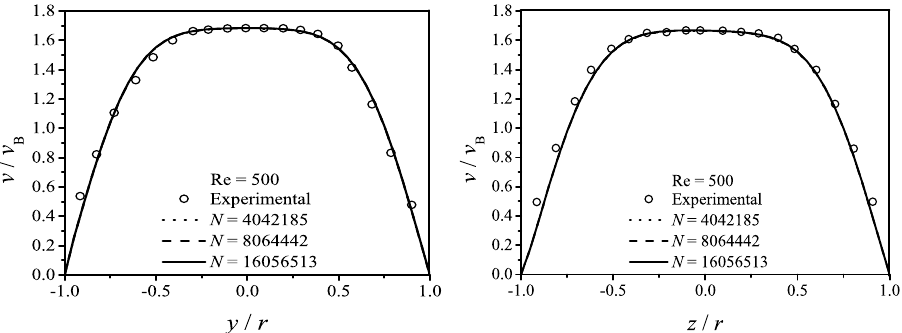
number is doubled from 500 to 1093, the thickness of the inlet boundary layer decreases from ≈ 0.26 D to ≈ 0.23 D , resulting in a larger central region (potential core) of uniform velocity. These features are also in very good agreement with the experimental observations.